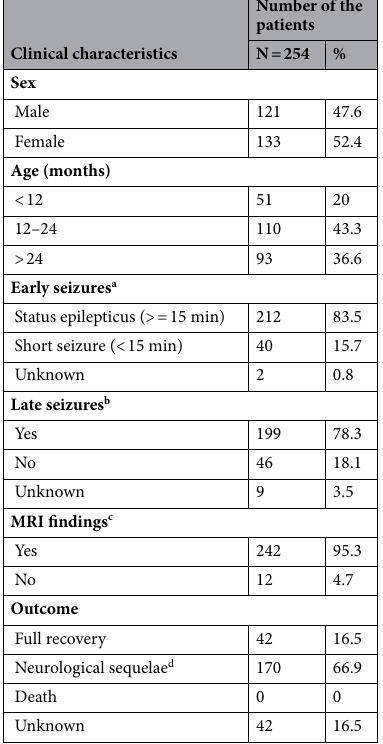
Table 1. Summary of clinical characteristics of patients with AESD in GWAS. a Early seizures: generalized convulsion in the early phase of AESD. b Late seizures: cluster of focal seizures in the late phase. c MRI findings: characteristic lesions in the cerebral subcortical white matter detected by cranial MRI. d Neurological sequelae: intellectual and/or motor